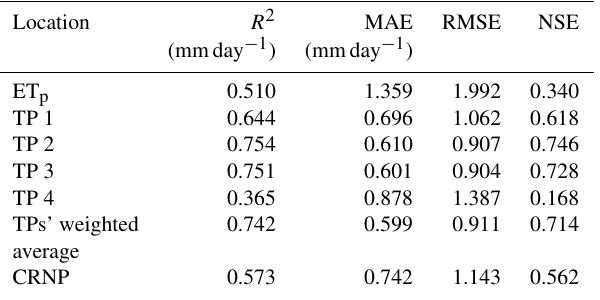
Table 6. Goodness-of-fit measures for simulated and observed daily ET a during the simulation period (2007–2012) at the study